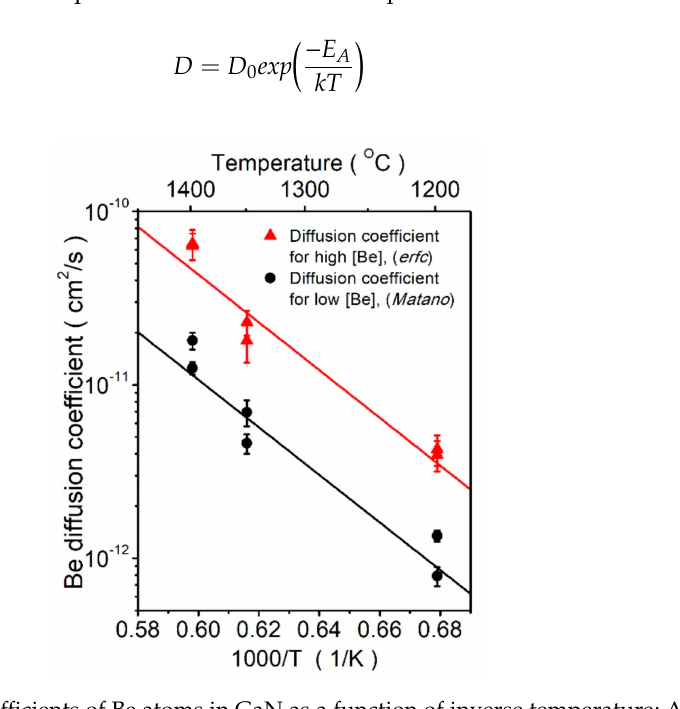
Figure 8. Di ff usion coe ffi cients of Be atoms in GaN as a function of inverse temperature; Arrhenius plot from erfc fitting (red filled triangles and line) and Matano analysis (black filled circles and line).